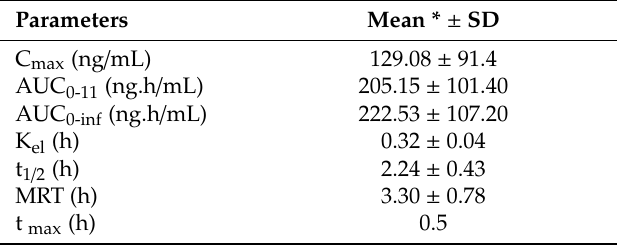
Table 4. Pharmacokinetic Parameters (Mean ± SD) of baracitinib Following Administration of 2 mg / kg to